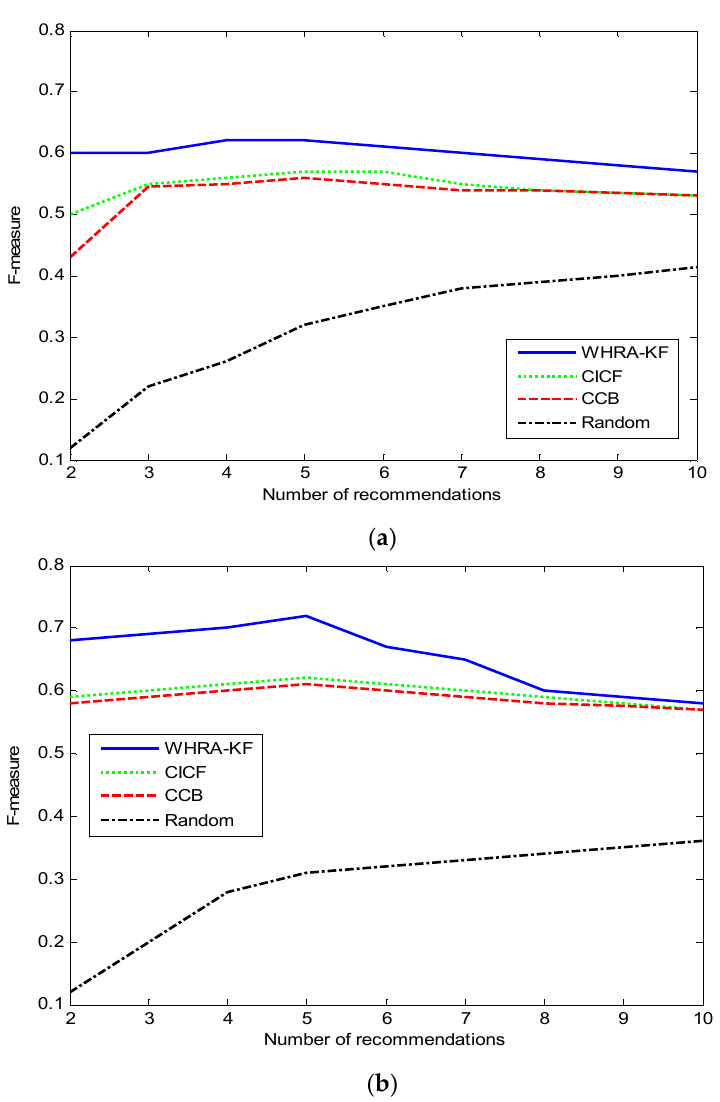
Figure 10. F-measure VS number of recommendation for smart home, ( a ) 50 n ; ( b ) 100 n .